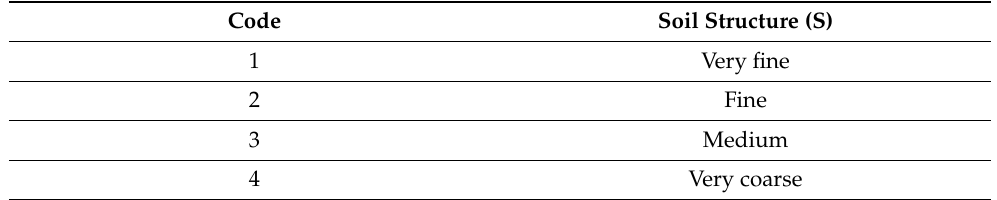
Table 1. Meaning of codes on soil